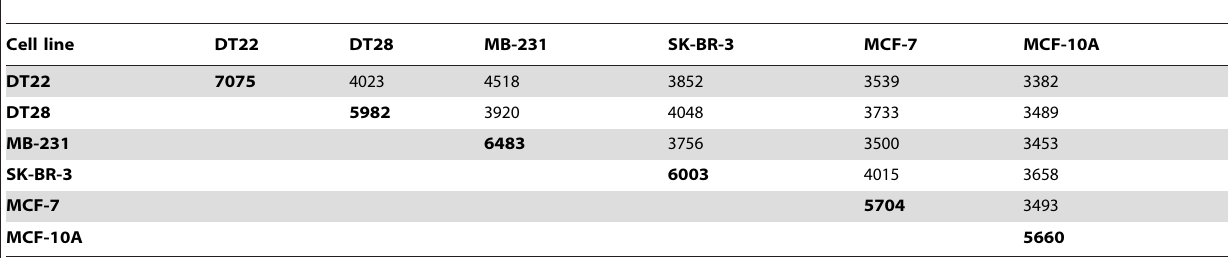
Table 2. Intersection of the protein data